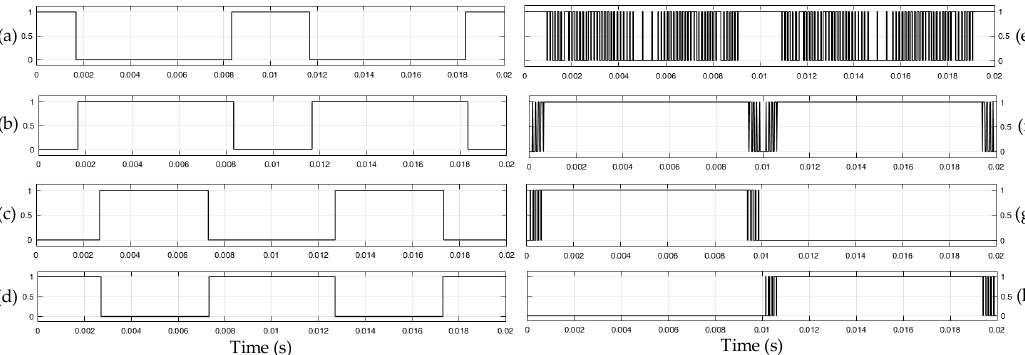
Figure 8. ( a ) gate pulses for S 1 (LGM); ( b ) gate pulses for S 2 (LGM); ( c ) gate pulses for S 4 , (LGM); ( d ) gate pulses for S 5 (LGM); ( e ) gate pulses for S a1 (AM); ( f ) gate pulses for S a2 (AM); ( g ) gate pulses for H 1 (PCU); and ( h ) gate pulses for H 3 (PCU) .